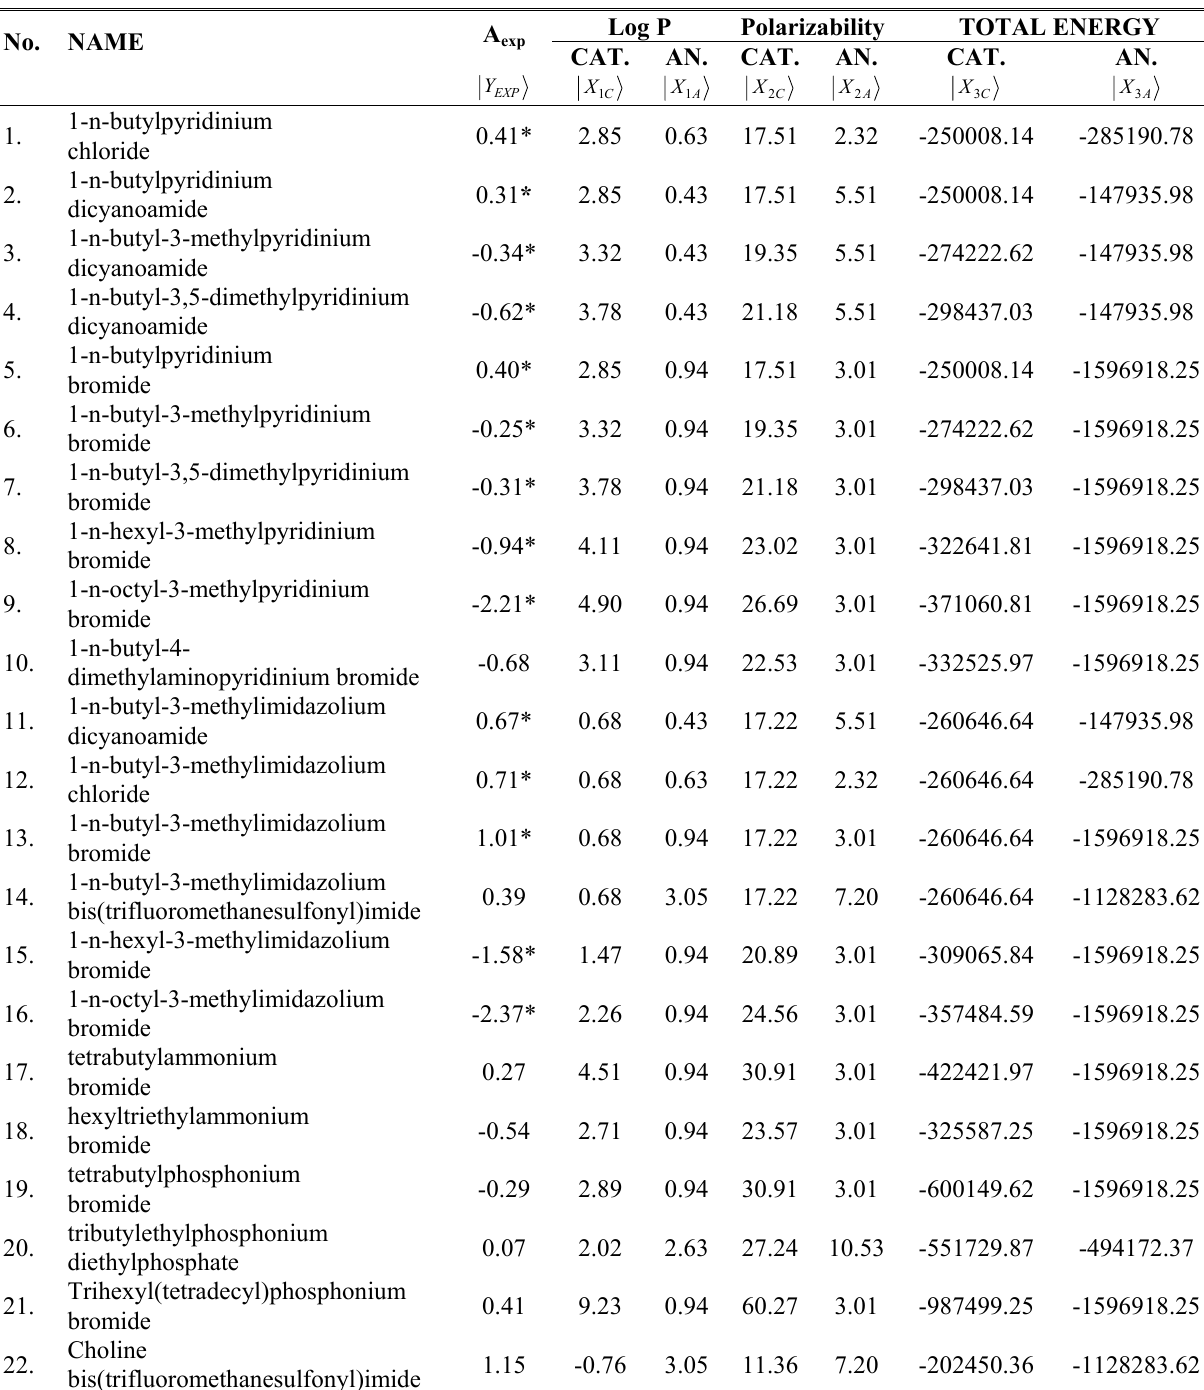
Table 2: The series of the ionic liquids of Figure 2 of those toxic activities A = Log(EC fischeri were considered [24], with the marked values taken from [4], along structural parameters (kcal/mol) as accounting for the hydrophobicity, electronic (polarizability) LogP , POL (Å 3 ), and E TOT and steric (total energy at optimized 3D geometry) effects, computed with the help of HyperChem program [25], for each cation and anion containing ionic liquid,